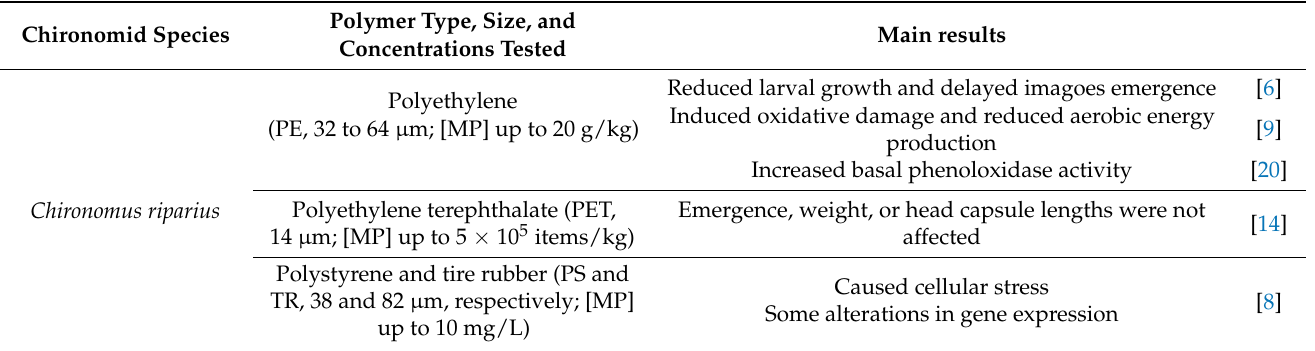
Table 1. Summary of the impact of microplastics on Chironomids.